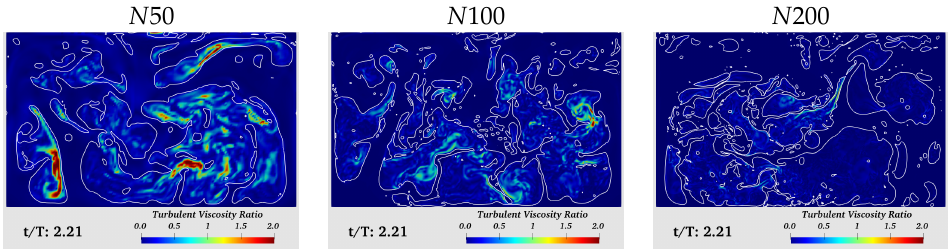
Figure 18. Two-dimensional oil E LEMENTAL ® turbulent viscosity ratio at different resolutions at t = 2.21 T